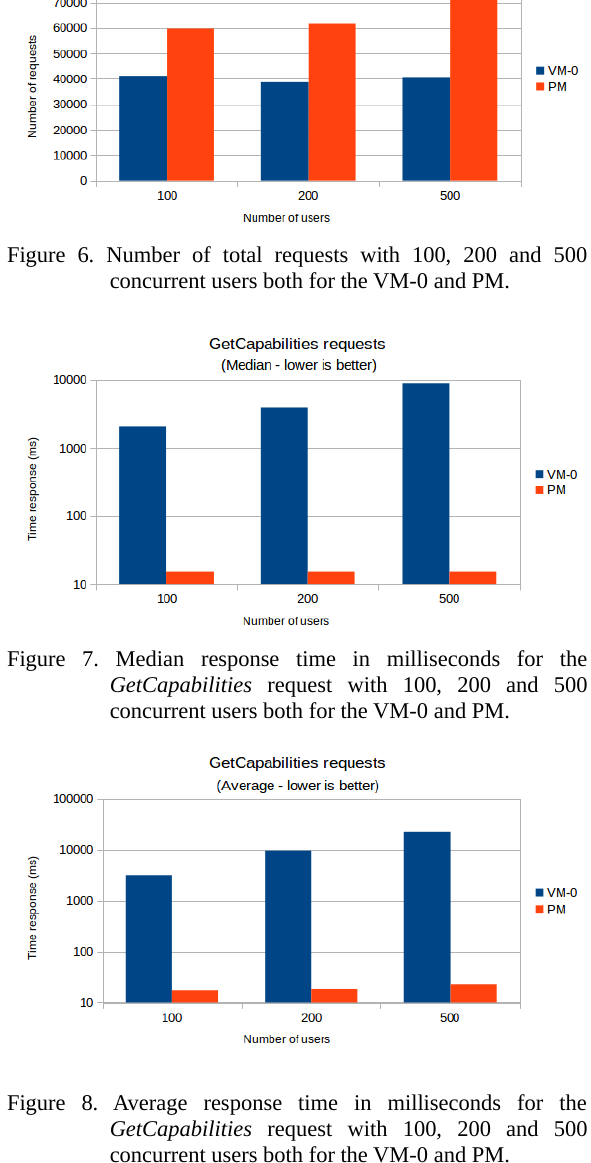
Figure 12. Average response time in milliseconds for the GetObservation request with 100, 200 and 500 concurrent users both for the VM-0 and